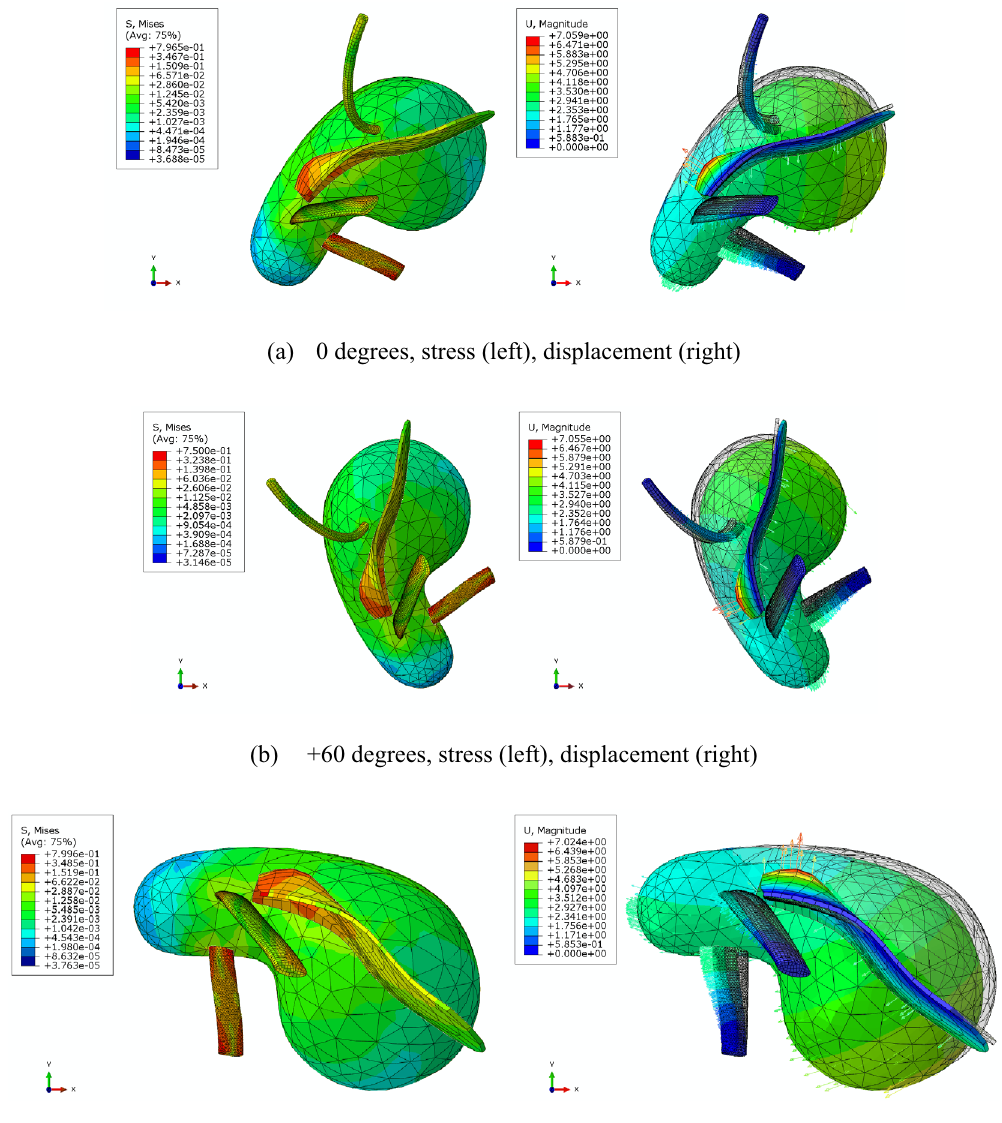
Figure 4. Distribution of displacement and stress in different postures. a 0 degrees, stress (left), displacement (right). b +60 degrees, stress (left), displacement (right). c −60 degrees, stress (left), displacement (right). (IAP = 10 kPa, created by Abaqus 2020, https:// www. 3ds. com/ zh/ produ cts- servi ces/ simul ia/ produ cts/